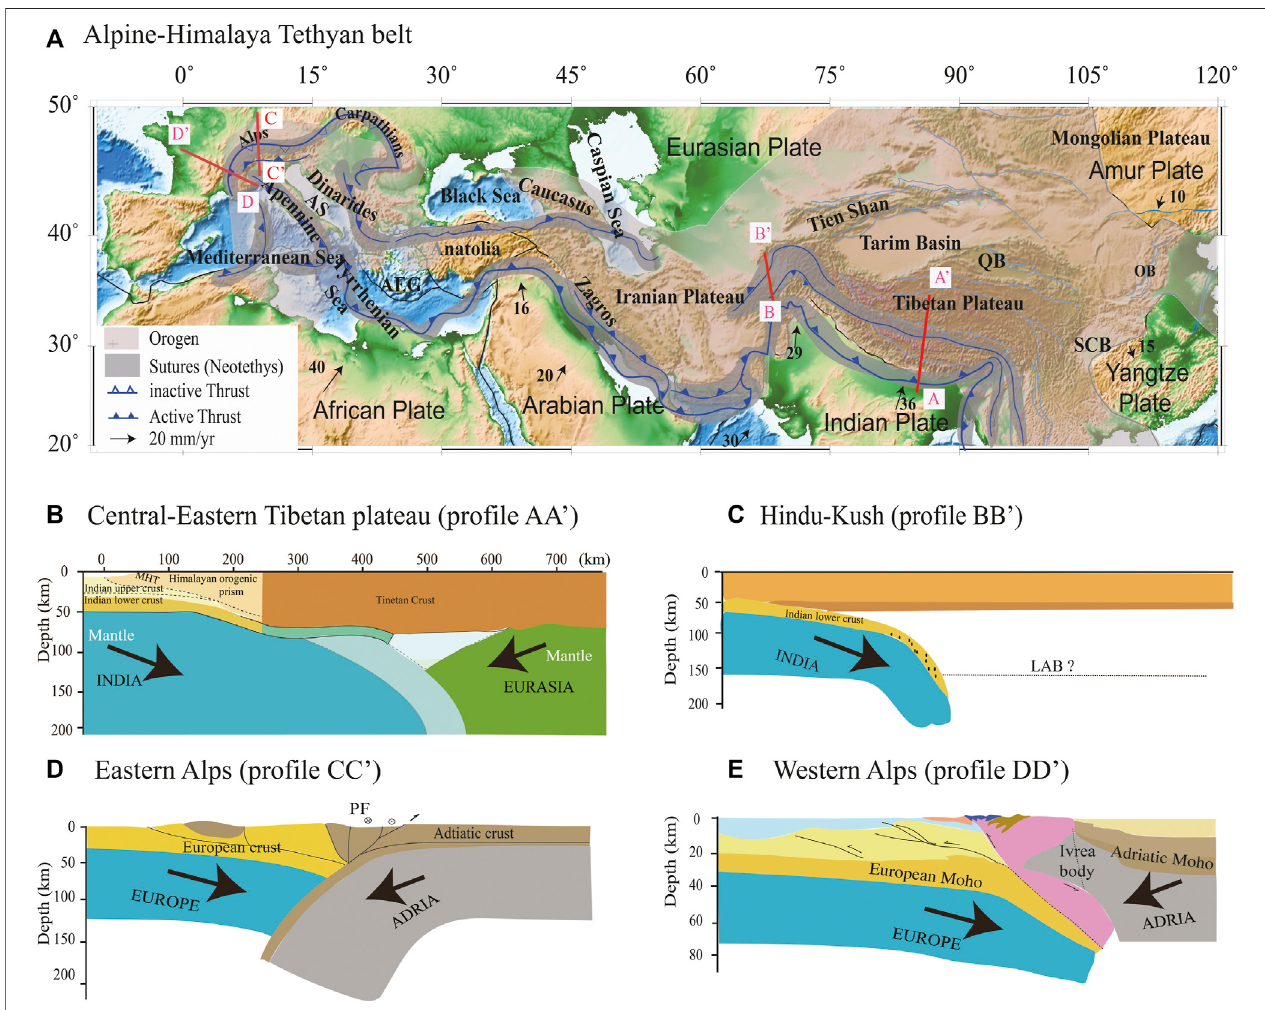
FIGURE 1 | (A) The Alpine – Himalayan Tethyan belt and main tectonic units along the collisional orogens. White and black lines outline the orogens and plate convergence boundary, respectively. Gray shadows mark the continental sutures since Cenozoic. Dark sawtooth blue lines show the main thrust belts, and light blue lines delineate the fi rst-order block boundaries around Tibet. Black arrows refer to the plate convergence direction with numbers denoting plate velocity. AS: Adria Sea, AEG:AegeanSea,QB:QaidamBasin,SCB:SichuanBasin,OB:OrdosBasins(Bird,2003;Lietal.,2011;SaeinandAfzal2017).Asimpli fi edschematicdiagramof the lithospheric structure of the collisional orogens is shown across (B) central-eastern Tibetan Plateau (AA ′ ) (Owens and Zandt, 1997; Tilmann and Ni, 2003; Nabelek et al., 2009; Mechie et al., 2012; Mechie and Kind, 2013; Ye et al., 2015; Huangfu et al., 2018), (C) Hindu Kush (BB ′ ) (Liang et al., 2020; Kufner et al., 2021), (D) eastern Alps (CC ′ ) (Lippitsch et al., 2003; Kissling et al., 2006; Handy et al., 2015), and (E) Austroalpine of the western Alps (DD ′ ) (Lippitsch et al., 2003; Kissling et al., 2006; Handy et al., 2010; Roda et al., 2010, 2012; Zhao et al.,